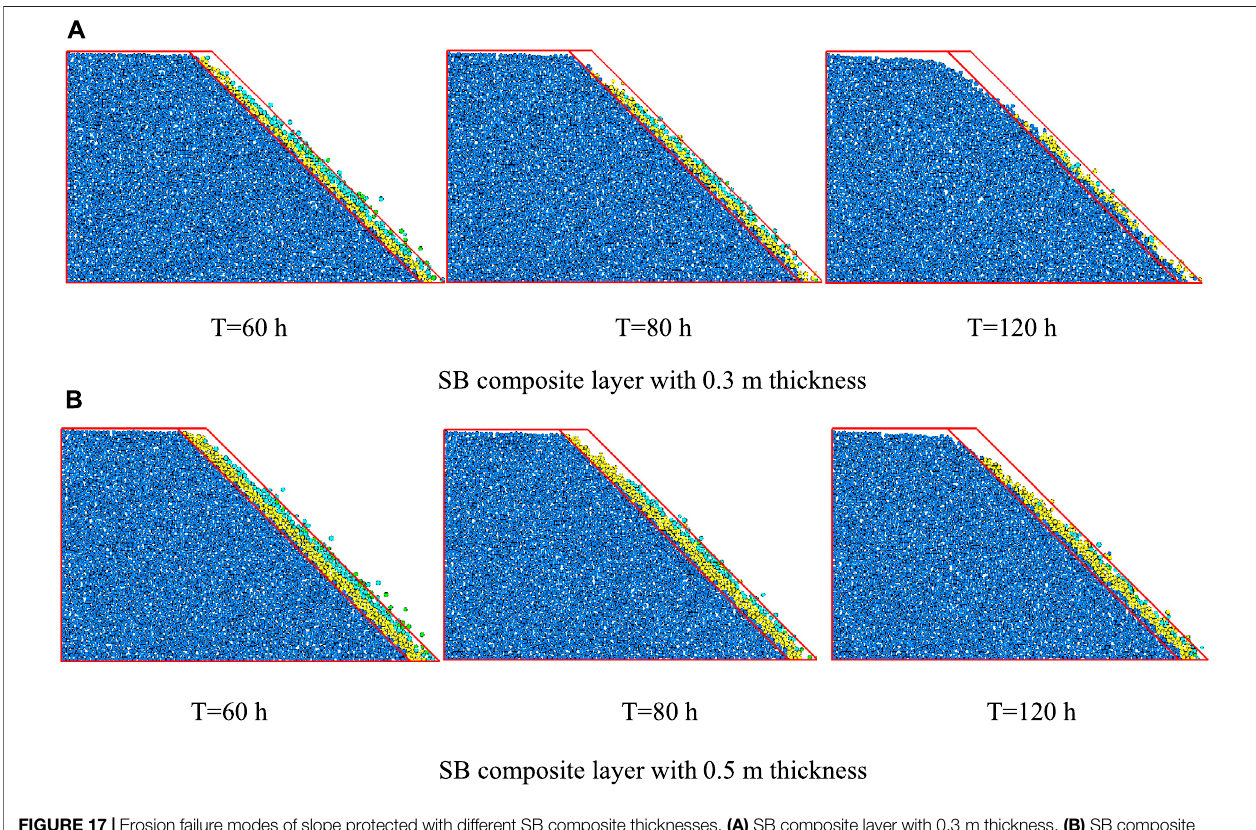
Frontiers in Earth Science |